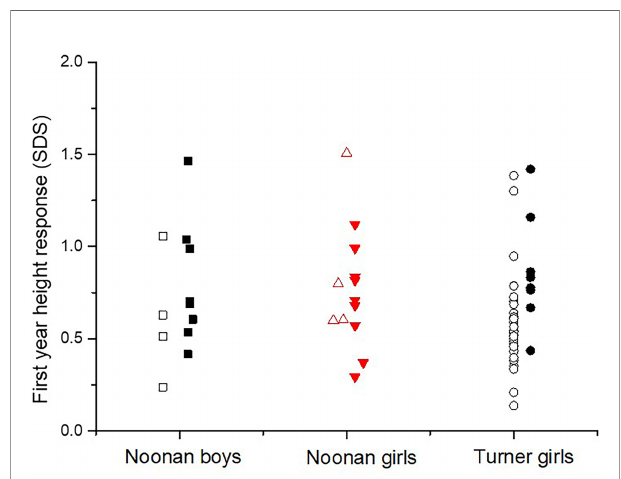
FIGURE 3 | The individual growth response as the fi rst-year delta height SDS in diagnosed with Noonan or Turner syndrome subdivided by gender, on either rhGH 33 or 66 µg/kg/day (open fi gures respectively fi lled fi